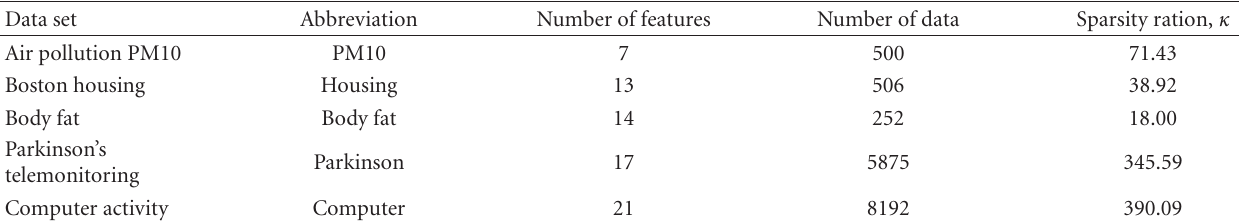
Table 2: Description of data used in the